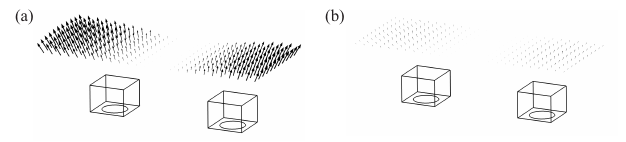
Figure 8: Active sound intensity on plane at h /2 behind the SNSs for h / λ = 0.18 . (a) primary, (b) residual